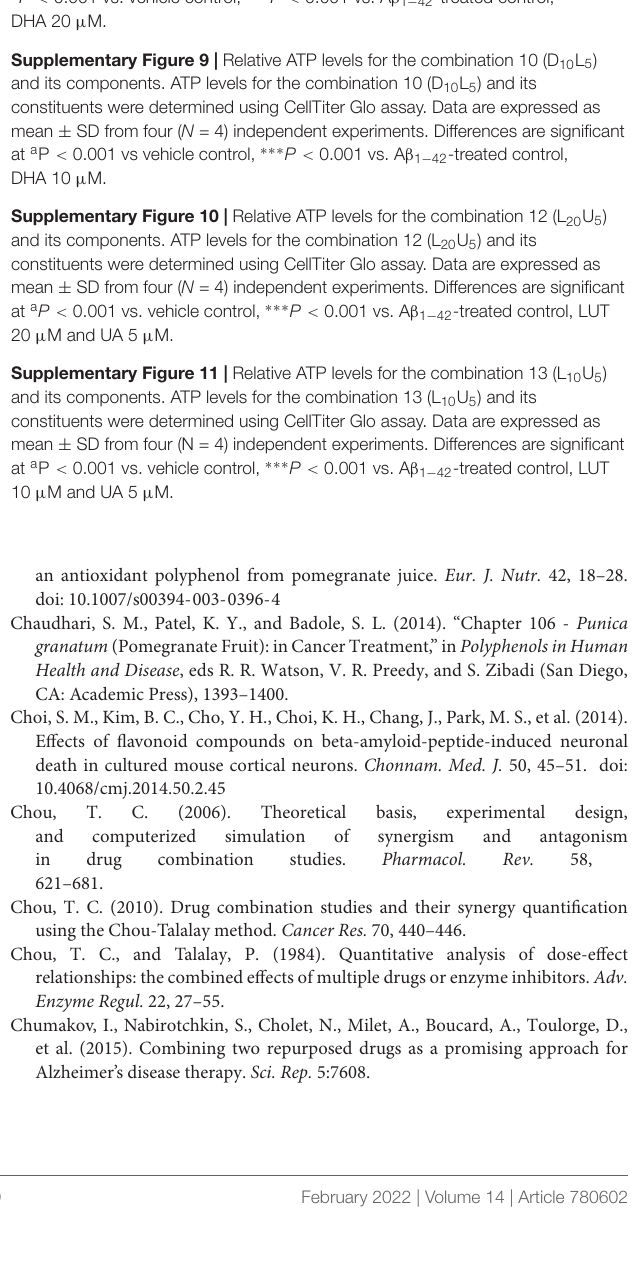
were determined using CellTiter Glo assay. Data are expressed as mean ± SD from four ( N = 4) independent experiments. Differences are significant at